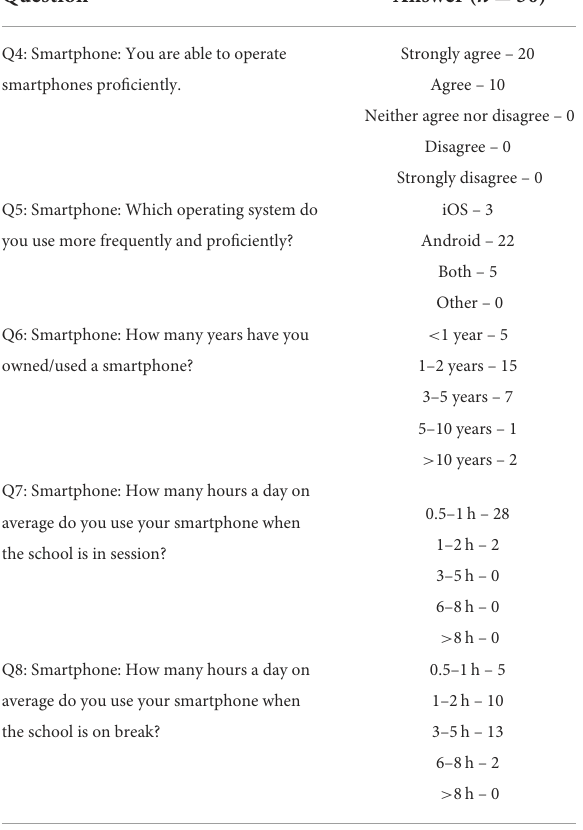
TABLE 1 Participants’ answers for Questions 4–8 in the demographic